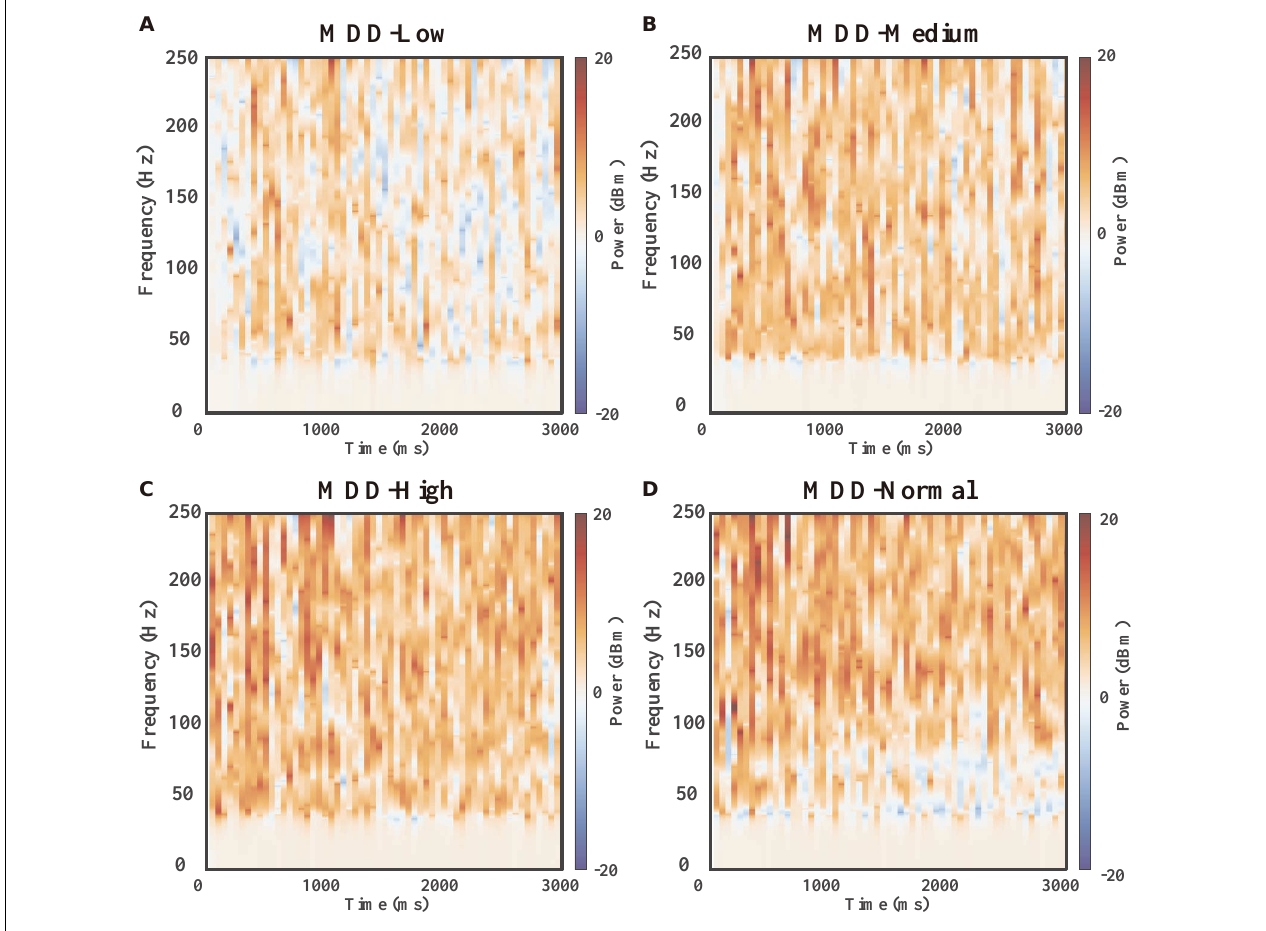
FIGURE 7 | Time-frequency power spectral results. The heat maps of the time-frequency power spectral results of field potentials between the MDD group (dopamine input: 0%) and dopamine groups(dopamine input: (A) low 25%, (B) medium 50%, (C) high 75%, and (D) normal 100%).